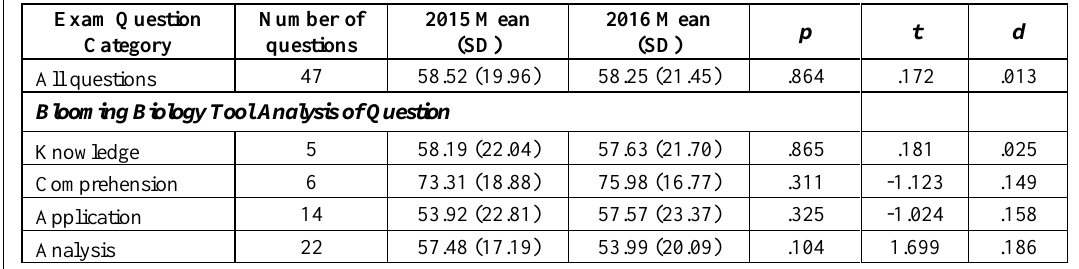
Table 2: Paired analysis of exam multiple choice questions before (2015) and after (2016) the implementation of the flipped classroom. Standard deviation (SD) is shown in